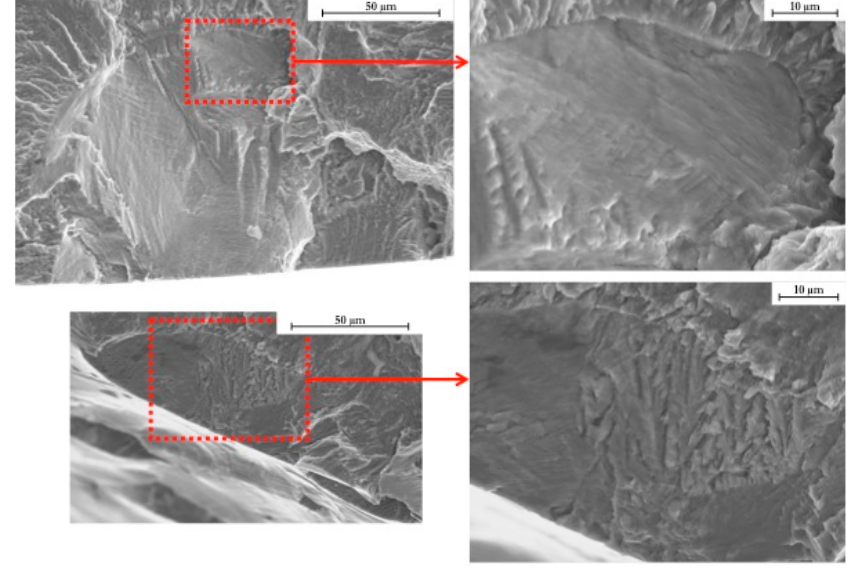
Figure 8. SEM observations of the fracture surfaces produced in air using the SIS B signal.